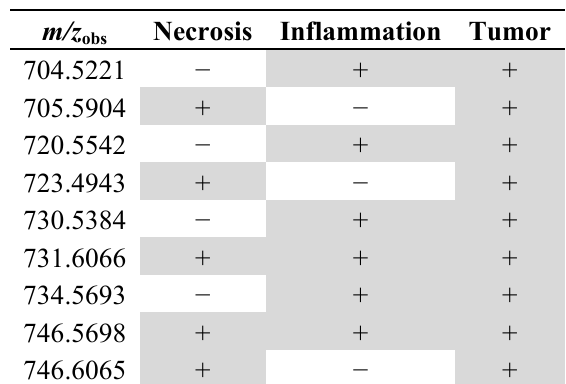
Table 2. Low-abundant PL species associated with two or three specific tumor areas detected during MALDI MSI analyses. Grey highlighted (+) corresponds to the localization of the PL species in